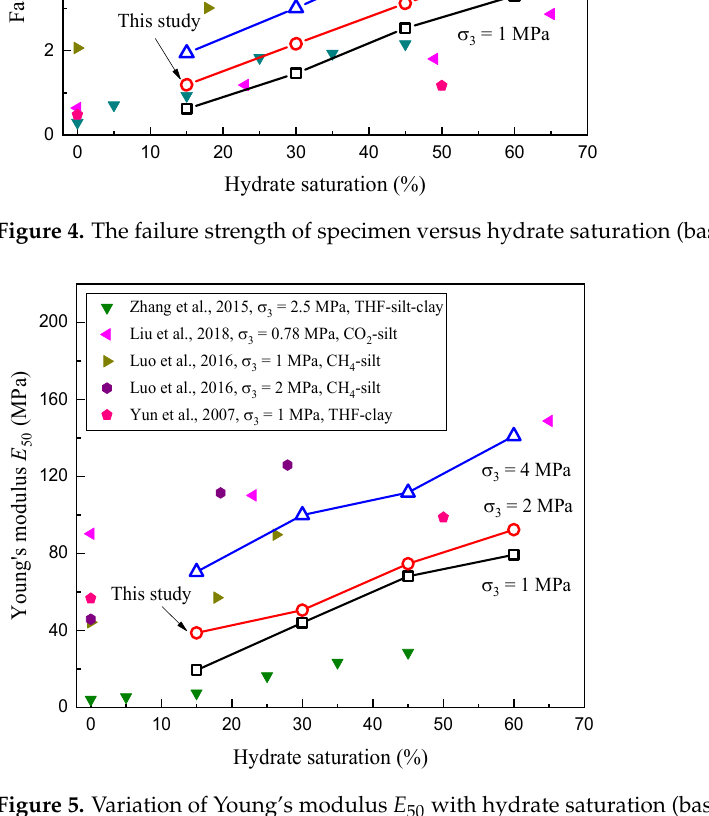
Figure 4. The failure strength of specimen versus hydrate saturation (based on [21–23,27]).